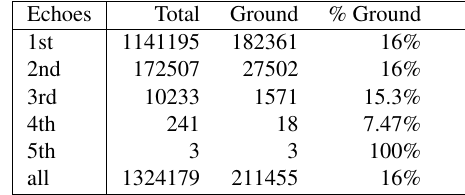
Table 2: Number of echoes and classified ground-points for the scanned forest area of 1 hectare size.